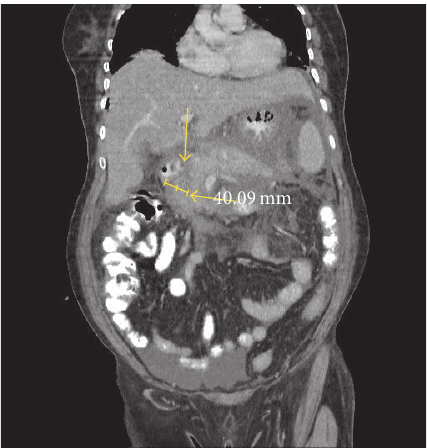
Figure 1: Arrows point to the diffuse enlargement in the size of the pancreas (40.09mm) (AP) (normal size of pancreas 10 mm up to 30 mm).